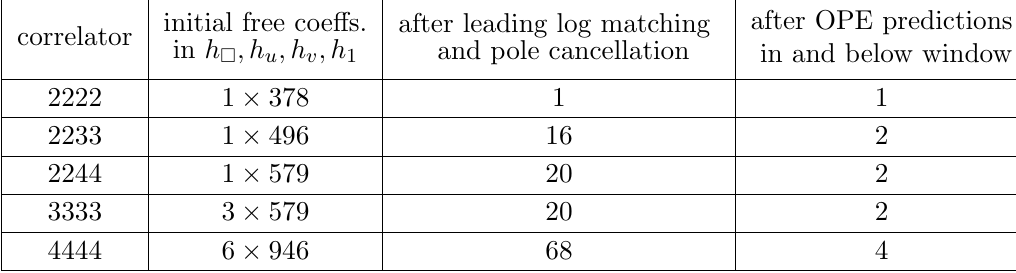
Table 1 . Number of tree-like free coe(cid:14)cients across the three steps of our